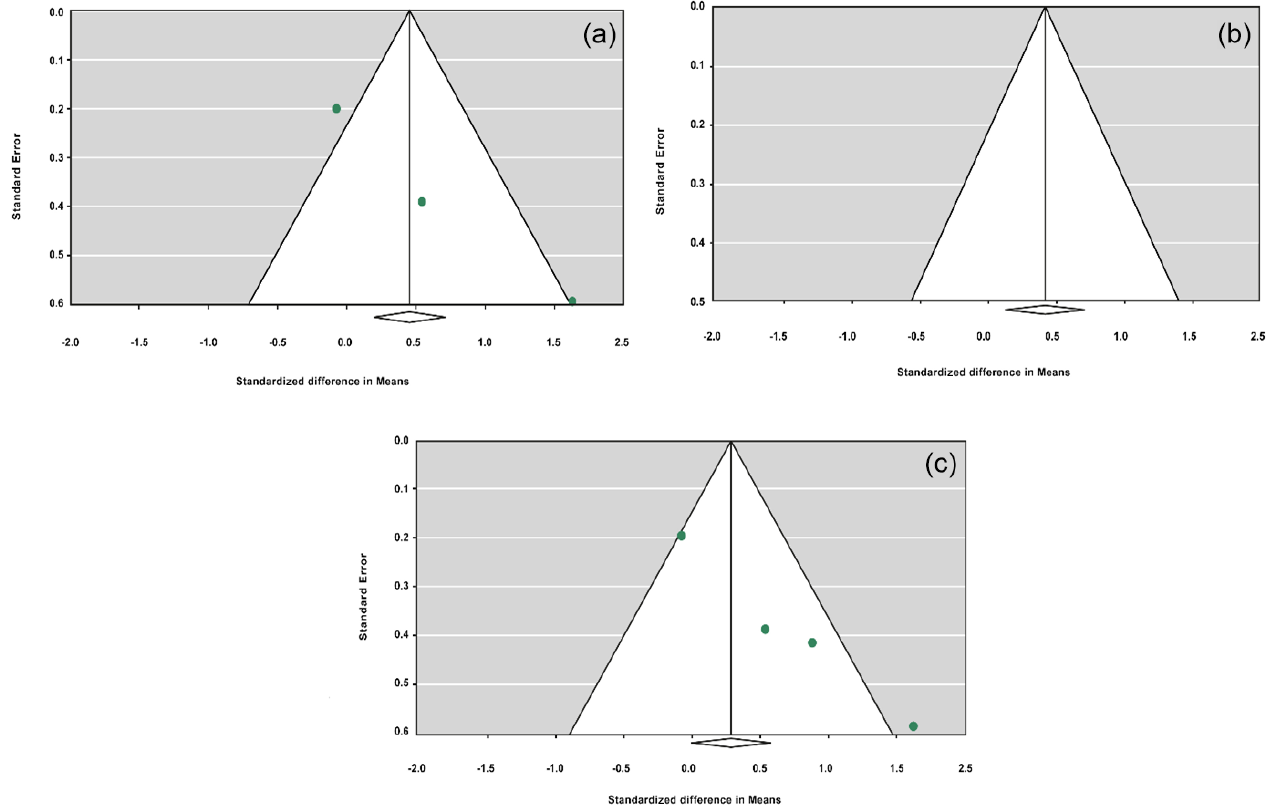
Figure 3. Funnel plots of sensitivity analysis under the additive model, with the Dong and Du (2010) Lubei White breed study removed (a) , the Feng et al. (2014) study removed (b) , and the Moghadaszadeh et al. (2015) study removed (c) . Table 6. Forest plot for association between c.963A > G polymorphism and litter size under additive model. For additional details refer